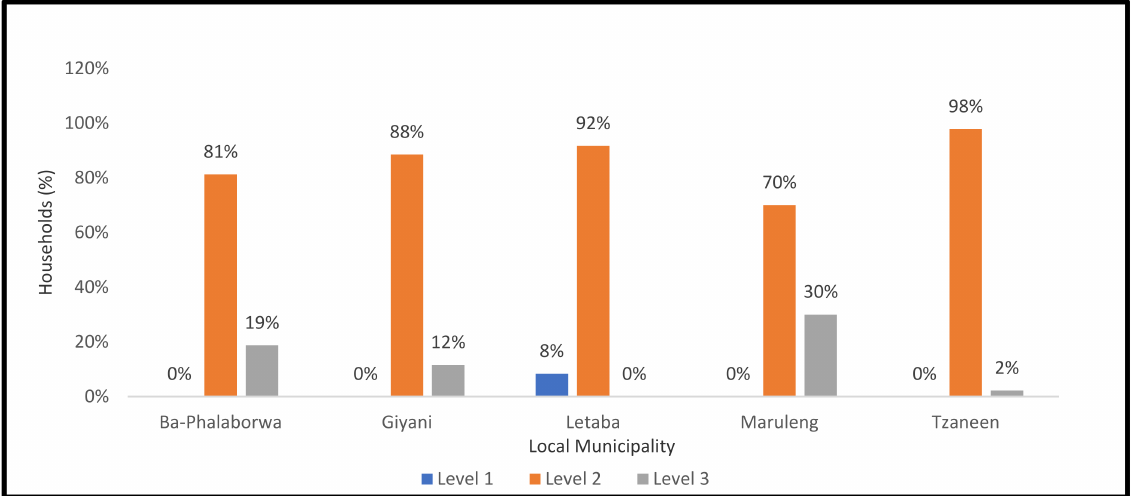
Figure 7. HVI per local municipality in Mopani District